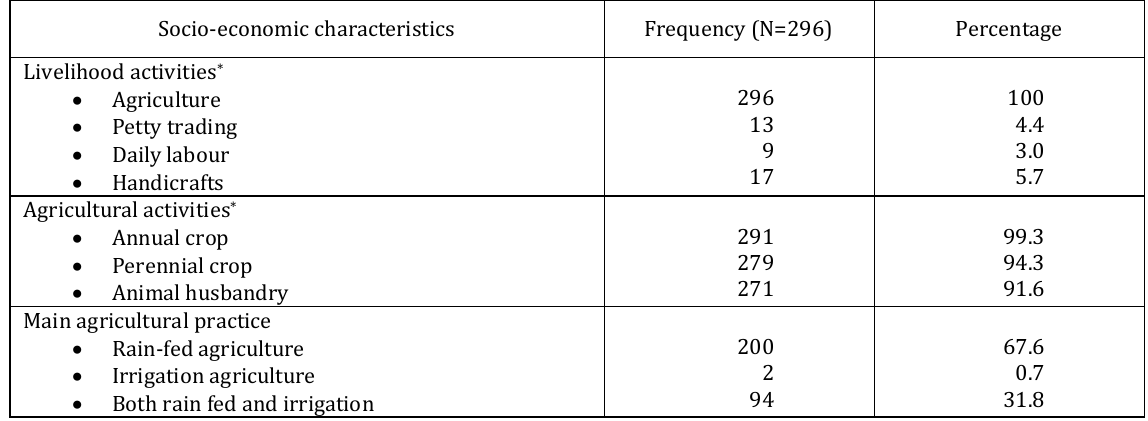
Table 2. Economic activities of the respondents (Source: survey result, April 2018) Socio-economic characteristics